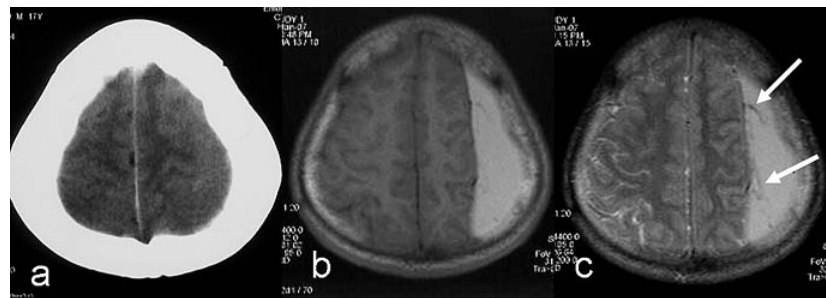
Comparison of extent of haematoma and determination of membranes on CT and MR imaging. a. Isodense haematoma is barely recognised on CT with the aid of sulcal effacement. b. Hyperintense haematoma with thin membranes (white arrows) is shown onT1W image. c. Membranes (white arrows) are clearly discernible onT2W